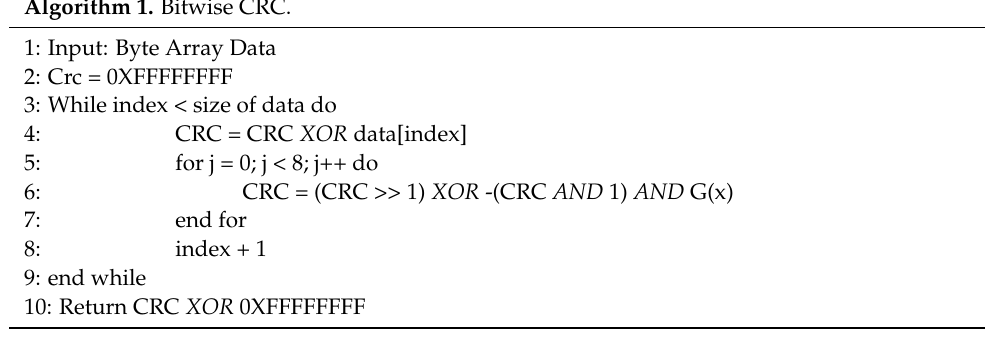
Algorithm 1. Bitwise CRC.